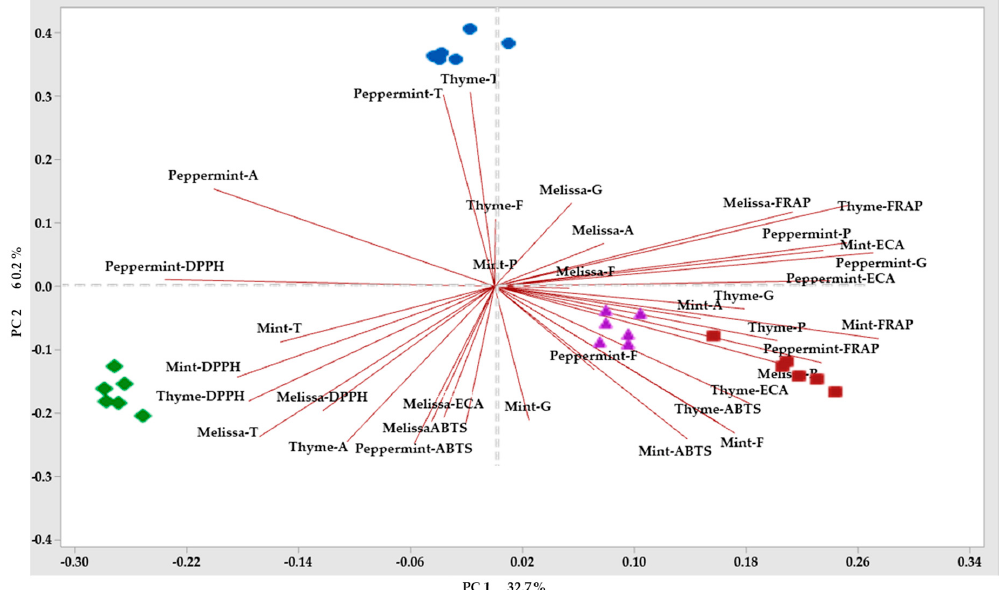
Figure 4. Principal component analysis (PCA) d) Phytochemical Compounds by drying method and plant materials [the di ff erent drying methods correspond to the Blue (Fresh plant), red (Microwave oven), green (Conventional) and violet (Freeze drying) icons] and [Acronyms per sample indicate P (Phenols), F (Flavonoids), T (Tannins), A ( α -amylase), G ( α -glucosidase), and ECA(Angiotensin converting enzyme)] [Red line indicates the direction of the maximum variance of the data to orthogonal axes of each